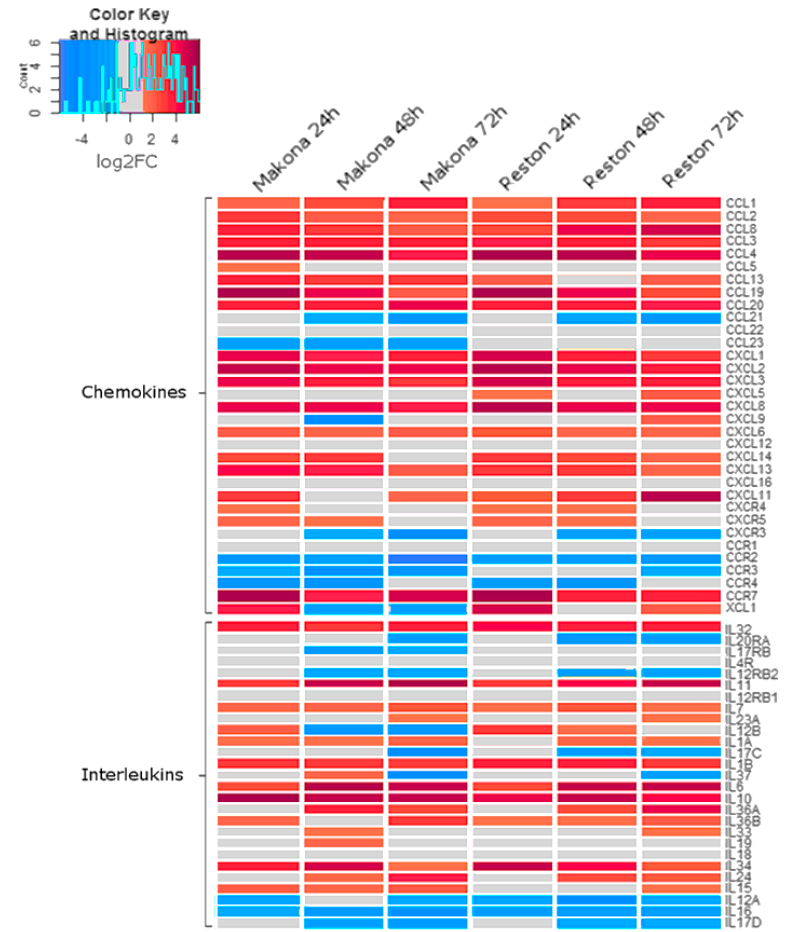
Figure 4. Heatmap showing log2FC in transcript abundance of transcripts encoding genes identified as “chemokines” or “interleukins” compared with mock-infected cells. Five categories of genes are shown, separated by chemokine classification (CC, CXC, CXCR, CCR, and XC); interleukin is shortened to IL for the names of these transcripts. A colour scale bar is provided to aid interpretation, showing change in colour from − 6 (“Blue”) to + 6 (“Red”). A range of − 1 to + 1 log2FC indicated no change compared with mock-infected cells and is indicated by “Gray”. A histogram is shown in the scale bar, indicating the frequency that genes fall into a particular zone of the colour